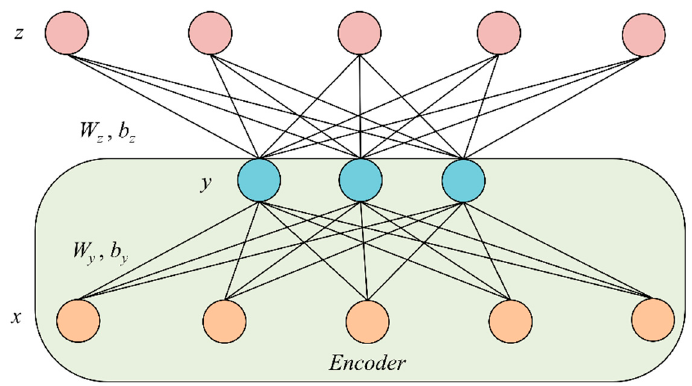
13 of 25 Figure 9. Procedure of AE-KDE-based anomaly detection. 3.2. AE-Based Time-Frequency Feature Prediction AE is a feed-forward and non-recursive neuronal network designed to reproduce its own input. In principle, AE can automatically extract certain hidden linear and non-linear structural relationships from the time-series data and learn the changing patterns of the data to implement data prediction. AE involves encoding and decoding steps where the encoding passes the input data to the hidden layer to generate latent mapping while de- coding maps the latent mapping to the reconstructed output. The decoder in AE only uses the latent variables in the hidden layer to perfectly reconstruct the original input, meaning that the latent variables retain sufficient information for the input. Thus, the nonlinear transformation obtained via learning with the use of model parameters defined in the hidden layer can be regarded as an advanced feature extractor [32]. This means that the